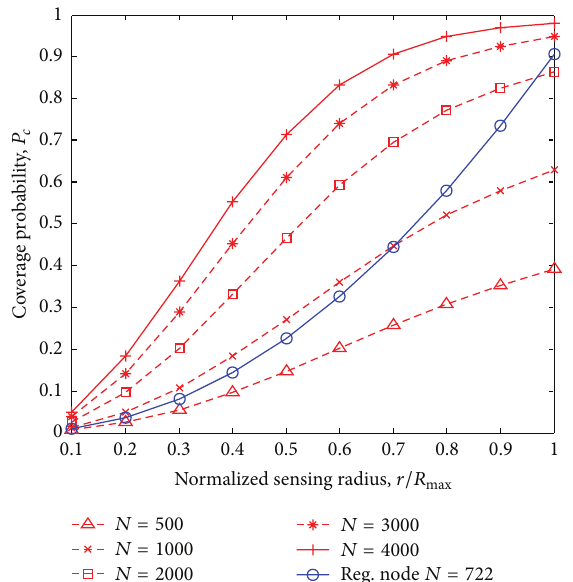
Figure 8: Coverage probability 𝑃 𝑐 for regular deployment scheme and random deployment